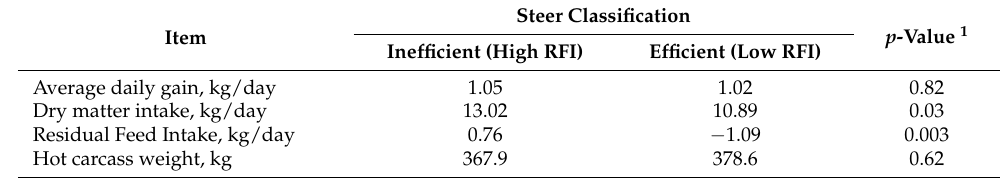
Table 1. Animal performance data observed during the feedlot-finishing period for steers differing in feed efficiency (assessed as RFI: Residual Feed